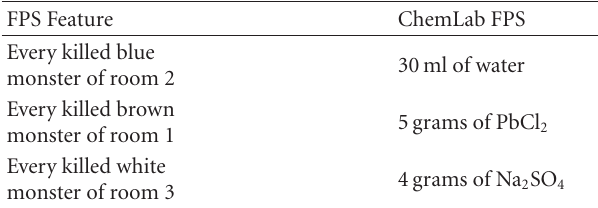
Table 3: Metaphorical correspondences for ChemLab